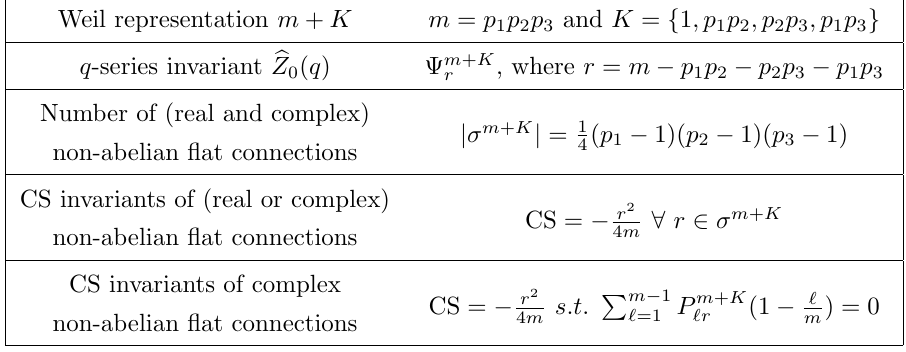
Table 12 . The modularity dictionary for Brieskorn spheres (cid:6)( p